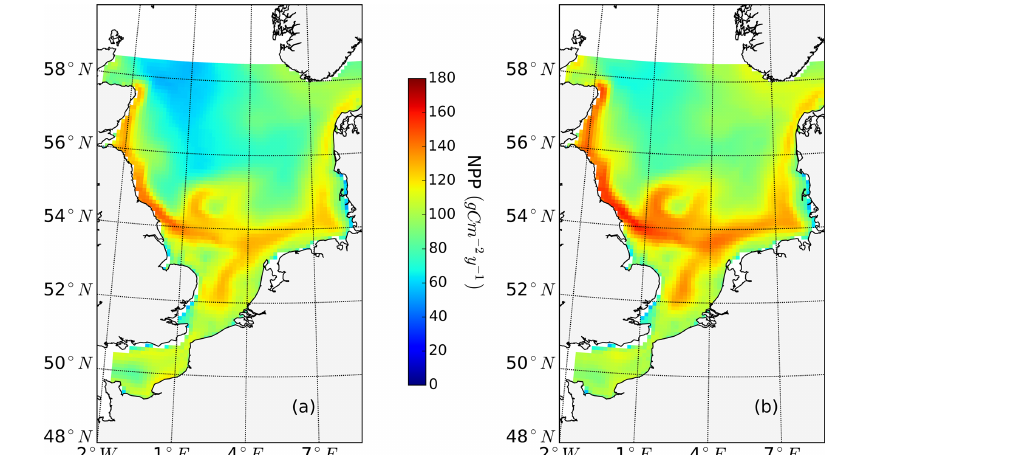
Figure B1. Mean annual net primary production for the analyzed period (1990–2015) simulated with the model configuration used by Daewel and Schrum (2013) (a) and the setup used in this study (b) .